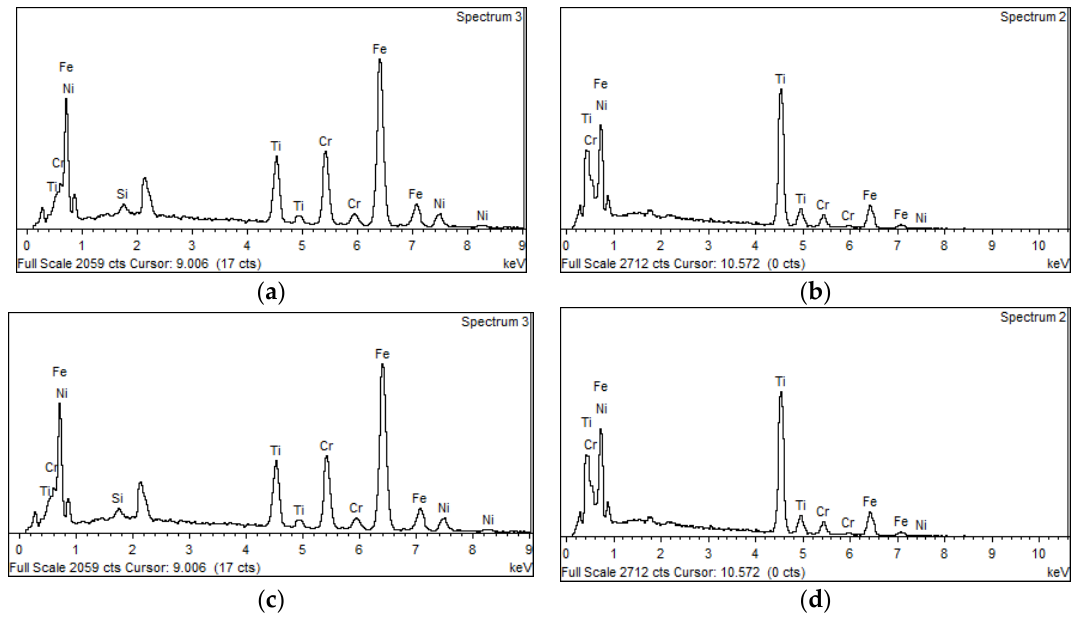
Figure 9. Distribution of elements Ti and Fe along the axis line of weld.